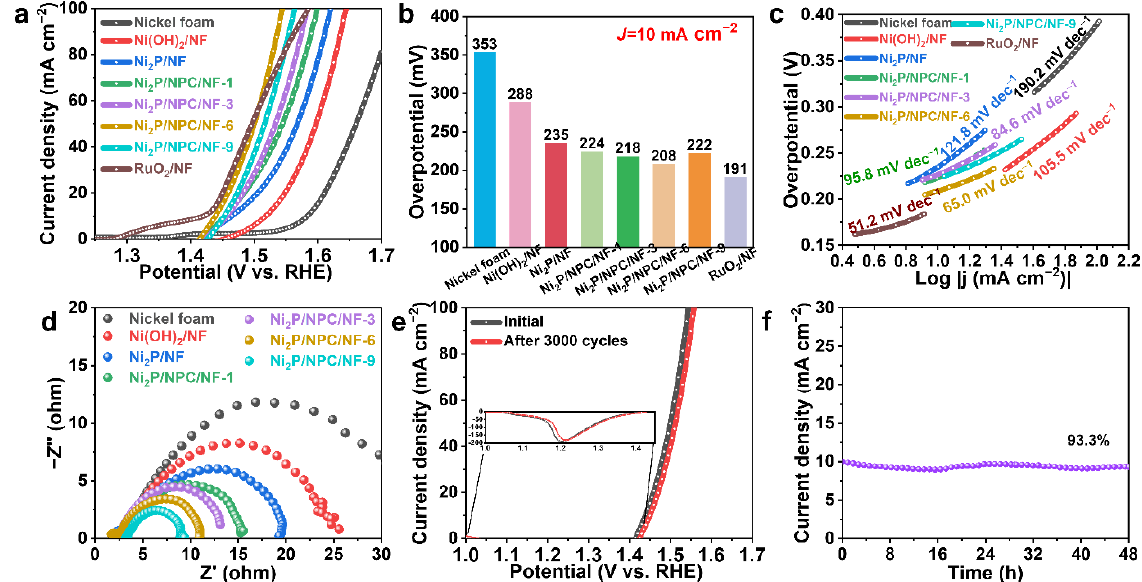
Figure 6. Diagrams of OER’s catalytic performance: ( a ) polarization curves, ( b ) corresponding over- potentials at 10 mA cm − 2 , ( c ) Tafel curves, ( d ) Nyquist plots of Ni(OH) 2 /NF, Ni 2 P/NF, Ni 2 P/NPC/NF, Ni 2 P/NPC/NF-1, Ni 2 P/NPC/NF-3, Ni 2 P/NPC/NF-6, Ni 2 P/NPC/NF-9 and RuO 2 of OER in 1 M KOH solution. ( e ) LSV curves of Ni 2 P/NPC/NF-6 before and after 3000 cycles in 1 M KOH solution. ( f ) Timing current density curve for Ni 2 P/NPC/NF-6 under a constant potential (Overpotential = 208 mV vs. RHE) for 48 h.